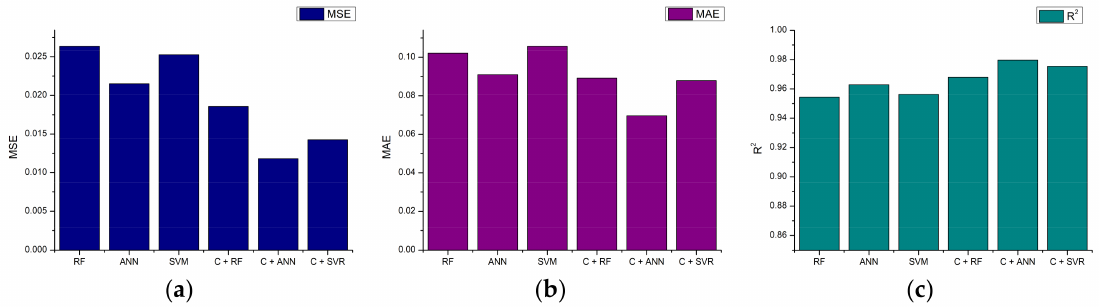
Figure 11. Comparison of predictors based on: ( a ) MSE; ( b ) MAE; ( c ) R 2